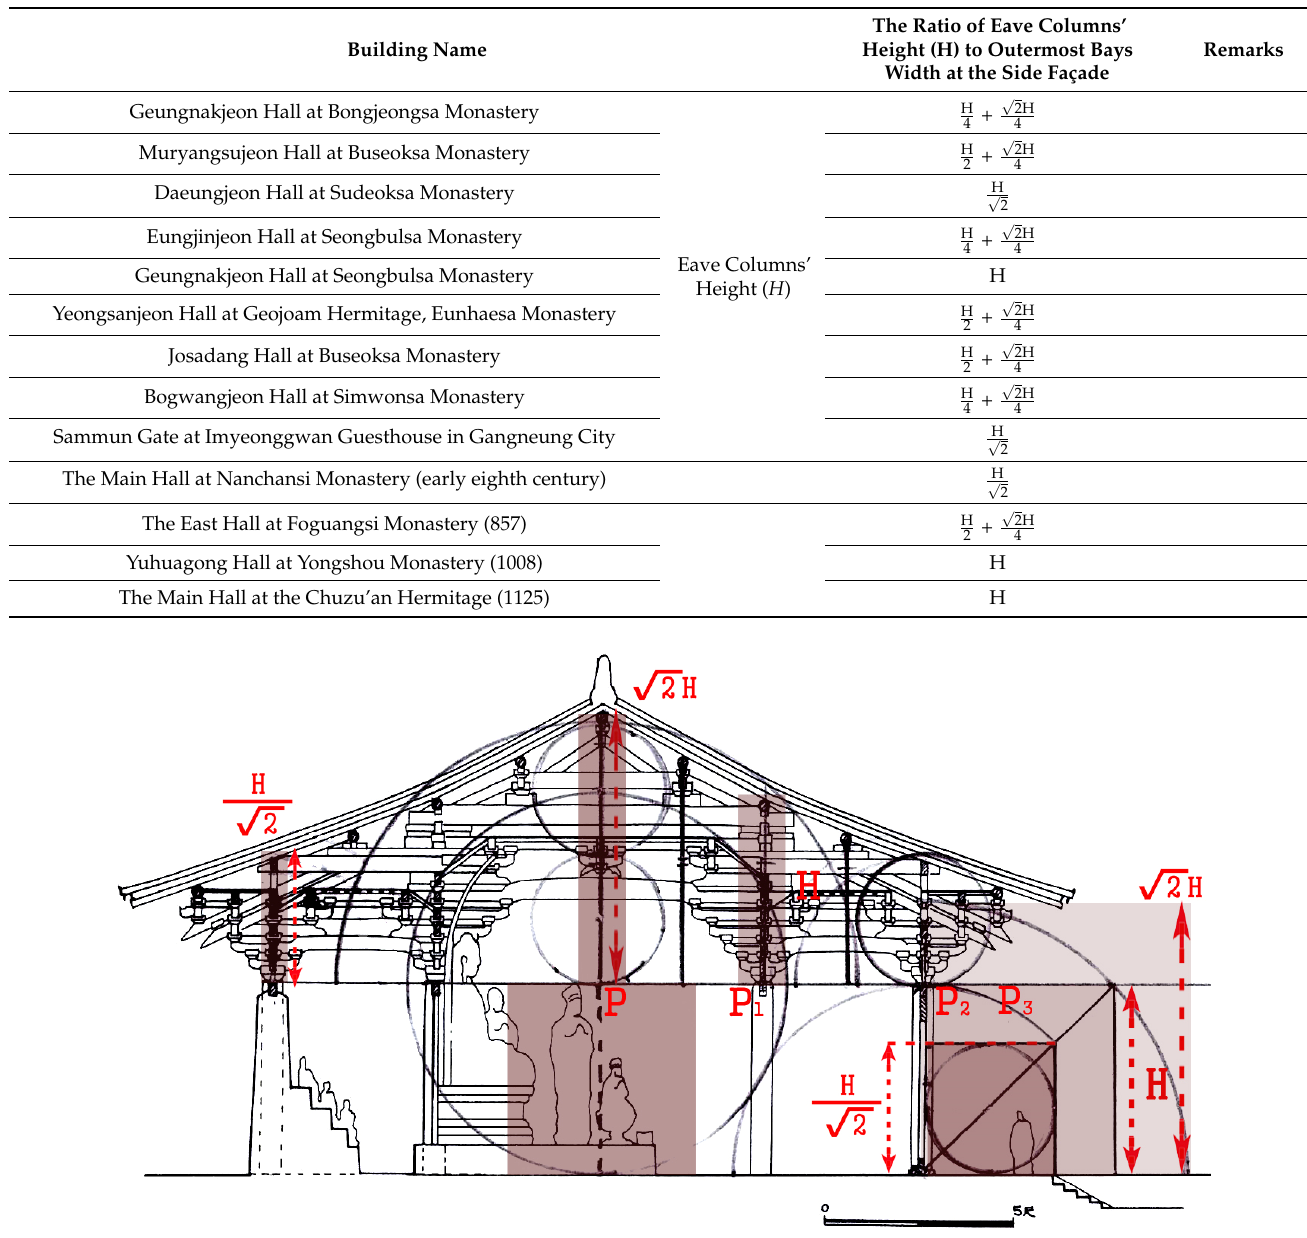
Figure 21. East Hall of Monastery Foguangsi. Proportional analysis of the sectional elevation (H = eave column height, Ø = circle diameter), Adapted from Fu (2001, p. 114).